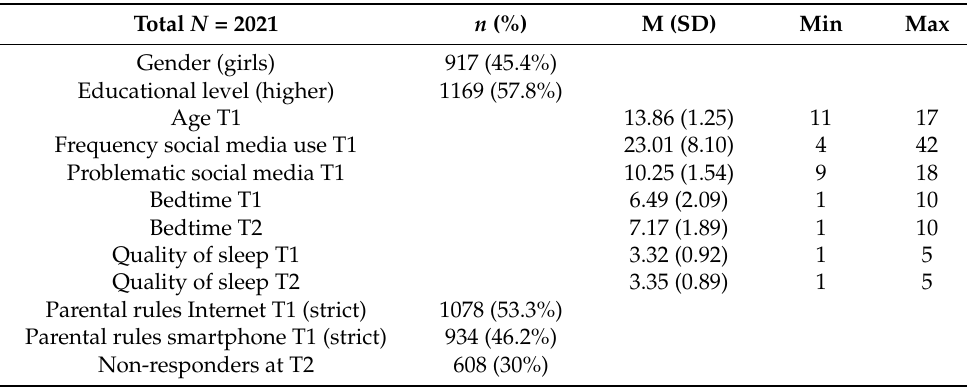
Table 1. Descriptive statistics of study variables.